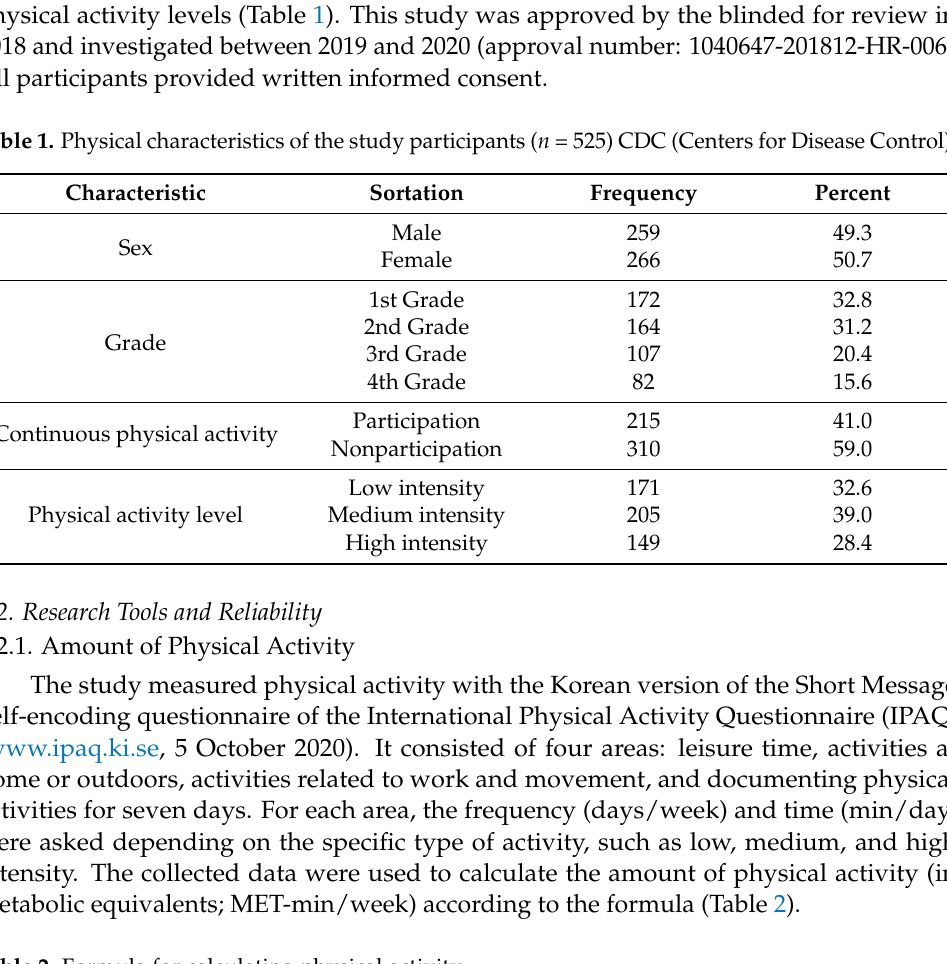
Table 2. Formula for calculating physical